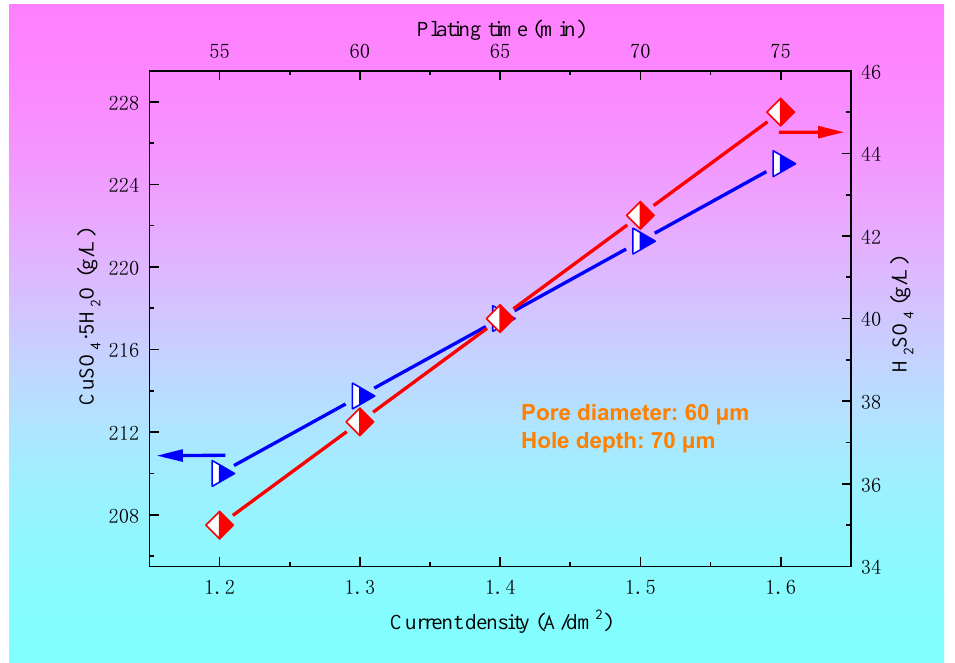
Figure 8. The relationships between the concentration of CuSO 4 ·5H 2 O and H 2 SO 4 and the plating solution formula for the blind hole with a diameter of 60 μm and a depth of 70 μm .